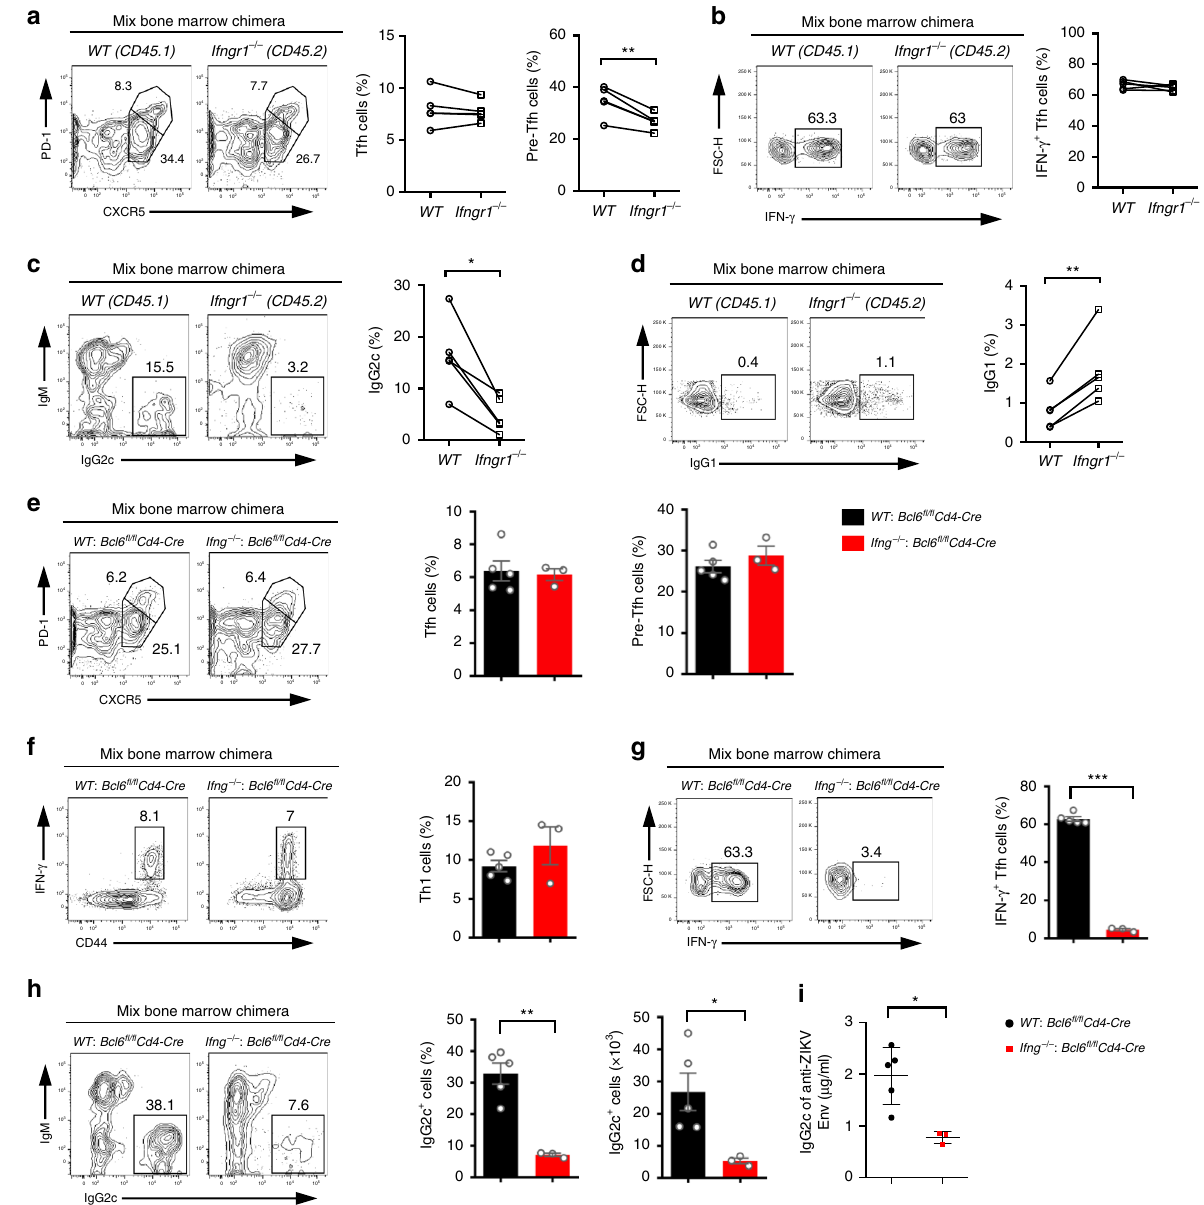
Fig. 8 IFN- γ produced by Th1-like Tfh cells is required in a B cell-intrinsic manner for IgG2c antibody class switching. a – d CD45.1 + WT: Ifngr1 − / − mixed bone marrow chimeras were administered with anti-IFNAR1 antibody 1 day prior to ZIKV infection. Splenocytes were collected on 14 dpi for measurement of Tfh cell and antibody responses ( n = 5). a Representative fl ow cytometry plots of CXCR5 high PD-1 high cells and CXCR5 medium PD-1 medium cells were presented as Tfh cells and pre-Tfh cells (Left panel); summary of the percentages of these cells (right panel). b Representative fl ow cytometry data of IFN- γ staining in splenic WT (CD45.1 + ) Tfh cells and Ifngr1 − / − (CD45.2 + ) Tfh cells at day 14 after ZIKV infection (left panel); summary of the percentages of WT or Ifngr1 − / − IFN- γ + Tfh cells (Right panel). c , d Representative fl ow cytometry data of IgG2c ( c ) and IgG1 ( d ) intracellular staining in B220 low CD138 + IgD low cells (left panel); summary of the percentages of these cells (Right panel). e – i WT : Bcl6 fl / fl Cd4- Cre chimeras, and Ifng − / − : Bcl6 fl / fl Cd4- Cre chimeras were administered with anti-IFNAR1 antibody one day prior to ZIKV infection ( n = 5 for WT: Bcl6 fl / fl Cd4- Cre group and n = 3 for Ifng − / − : Bcl6 fl / fl Cd4- Cre group). e Representative fl ow cytometry plots of CXCR5 high PD-1 high cells and CXCR5 medium PD-1 medium cells were presented as Tfh cells and pre-Tfh cells (left panel); bar graphs summarized the percentages of these cells (right panel). f Representative fl ow cytometry plots of IFN- γ + cells in CD4 + CXCR5 − T cells were presented as Th1 cells (left panel); bar graphs summarized the percentages of Th1 cells (right panel). g Representative fl ow cytometry plots of IFN- γ staining in CXCR5 high PD-1 high Tfh cells (left panel); the percentages of IFN- γ + Tfh cells were summarized by bar graphs (right panel). h Representative fl ow cytometry data of IgG2c intracellular staining in B220 low CD138 + IgD low splenocytes (left panel); bar graphs summarized the percentages and numbers of IgG2c + cells (right panel). i The concentrations of ZIKV envelope speci fi c IgG2c antibodies in chimeras were measured by ELISA. The summary data were presented as mean ± SEM. Statistical differences were determined by Student ’ s t test and p values were indicated by * p < 0.05, or ** p < 0.01, or *** p < 0.001. Data ( a – i ) are pooled from two independent technical duplicates. Source data are provided as a Source Data fi